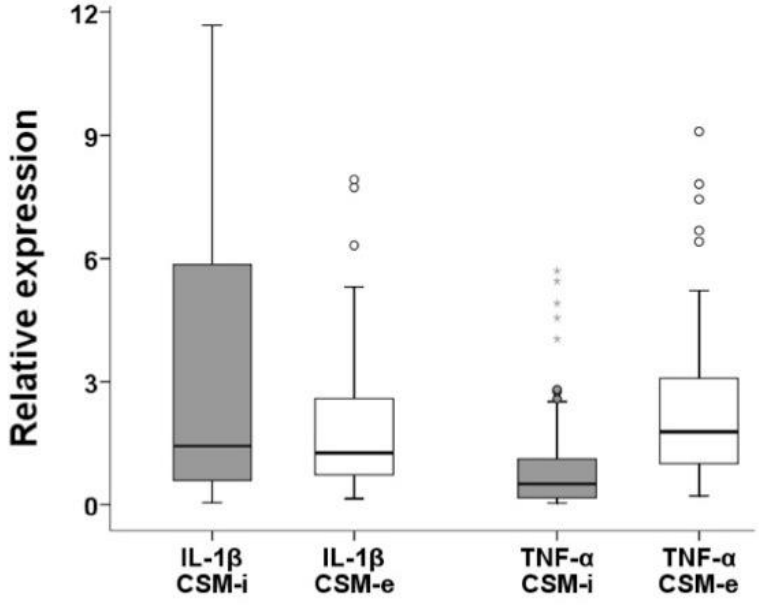
Figure 5. Relative expression levels of pro-inflammatory cytokines (IL-1β and TNF-α) comparing CSM-i to CSM-e. Outliers are marked separately with *.